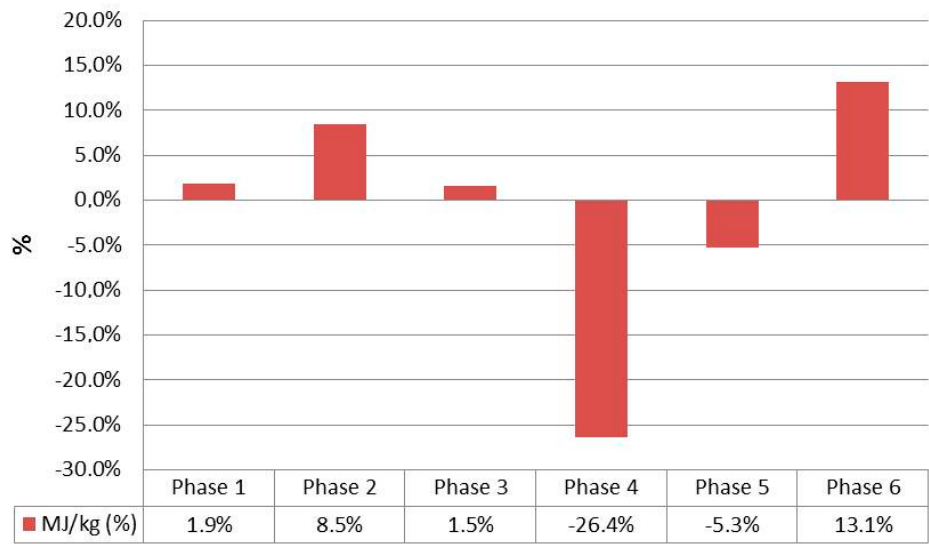
Figure 4. CO 2 emissions resulting from the difference between enzymatically-produced protein hydrolysate from lupine grains and chemically-produced protein hydrolysate from leather waste by industrial phase.